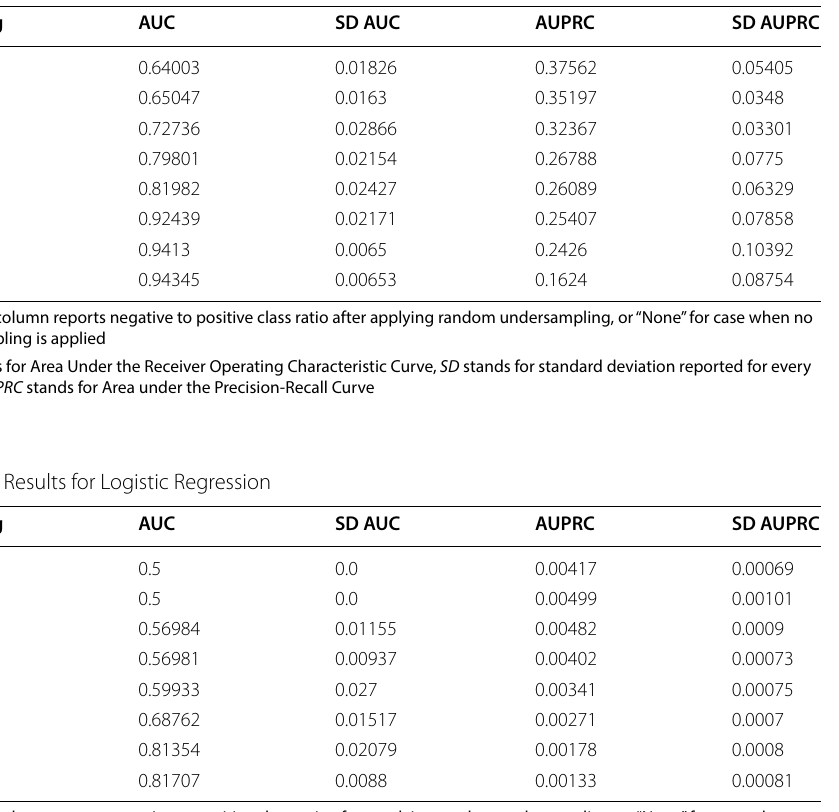
Table 8 Results for Random Forest